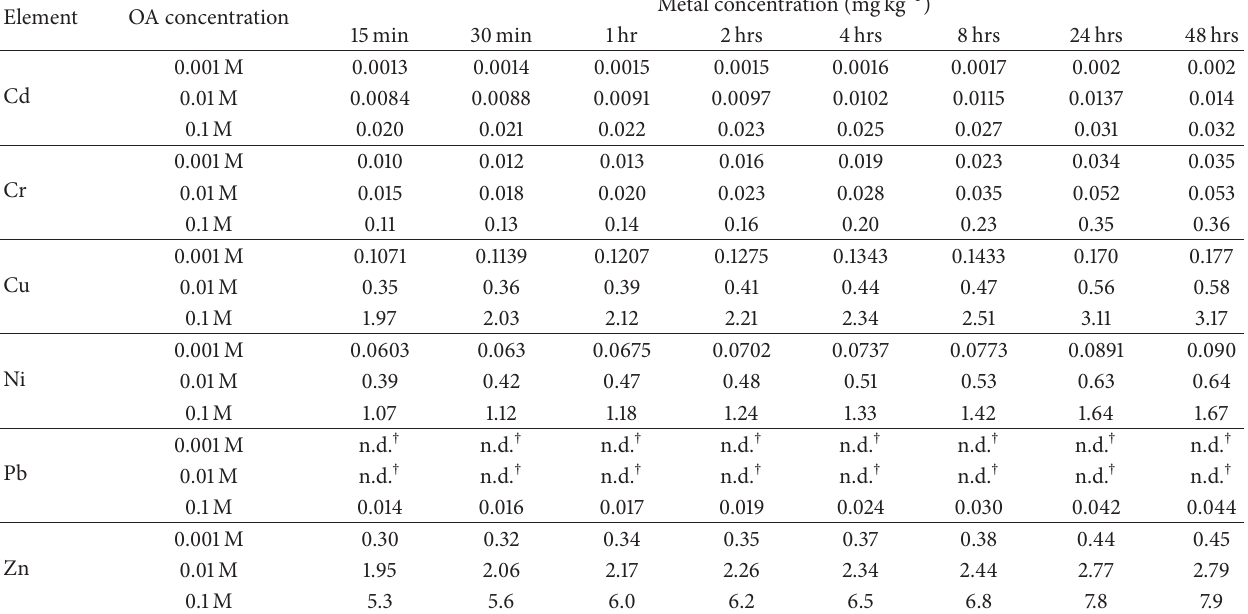
Metal concentration (mgkg −1 )